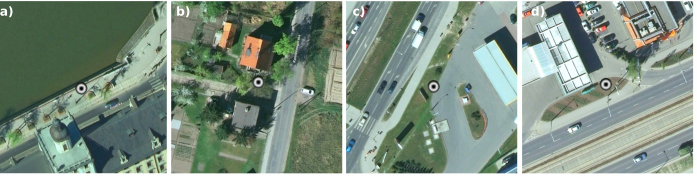
Figure 6. Typical land cover/land use for: ( a ) MIN (UID 0), ( b ) LGWT (UID 2), ( c ) HGWT (UID 8) and ( d ) MAX (UID 46). It shows that the proportion of green areas in the LGWT group is slightly larger than in HGWT or MAX groups. The well or piezometer is located in the center of each